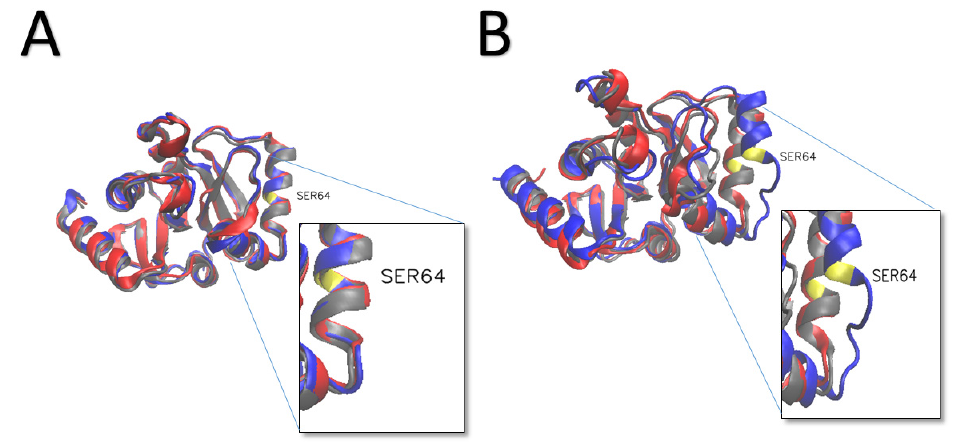
Figure 6. Changes in NSP3 structure with phosphorylation. The three simulated structures at time 100 ns (gray—WT, blue—S64, Red—T154). ( A ) at 0 nanoseconds; ( B ) after 100 nanoseconds.